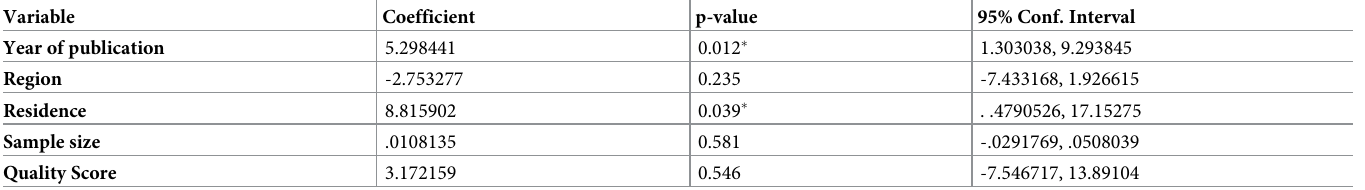
Table 3. Meta-regression of the proportion of AIS by year of publication, region, residence, sample size, & quality score to detect the source of heterogeneity in Ethi- opia, 2013–2020 (n = 28).